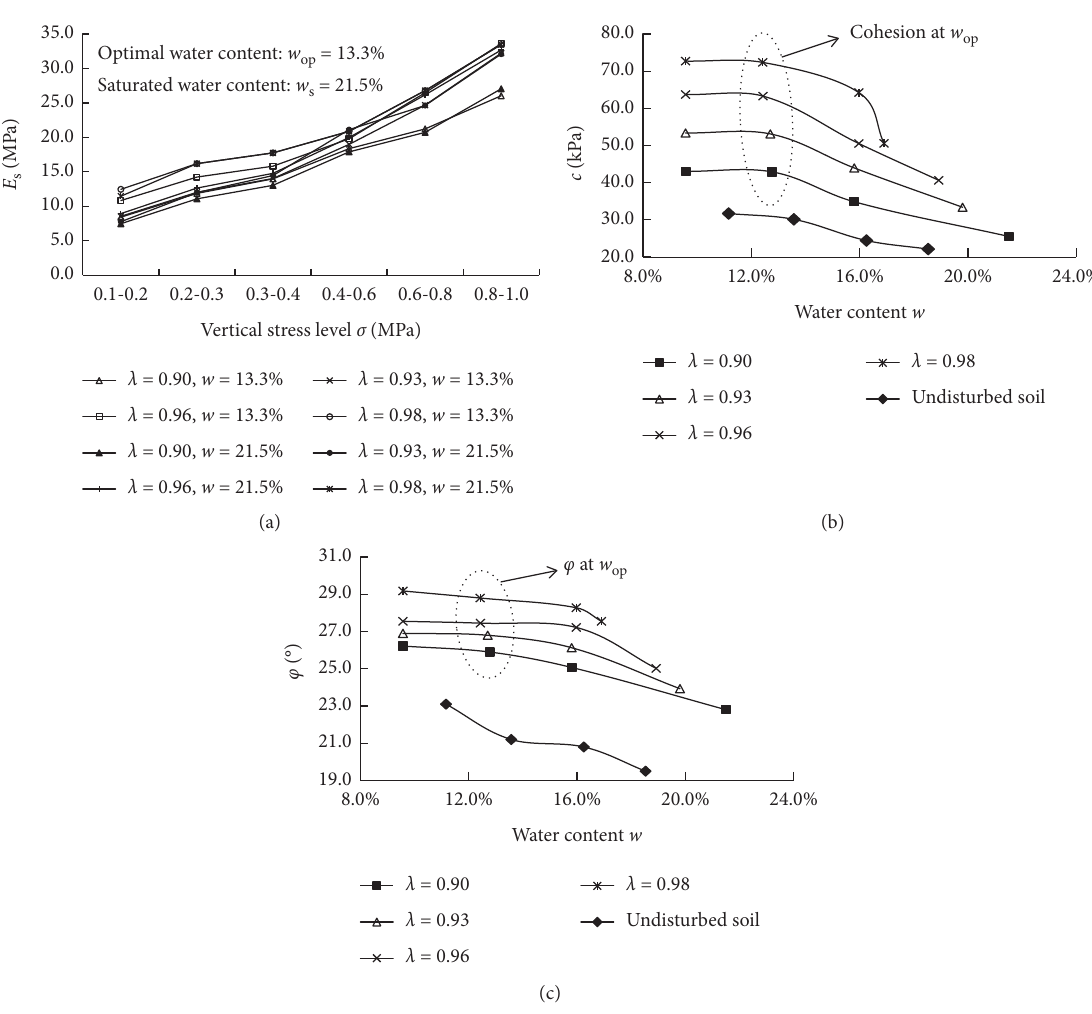
Figure 6: Mechanical parameters of compacted Q 3 loess. (a) Compression modulus of soil samples at various stress levels. (b) The cohesion of soil samples at various compaction degrees and water contents. (c) Internal friction angle of soil samples at various compaction degrees and water